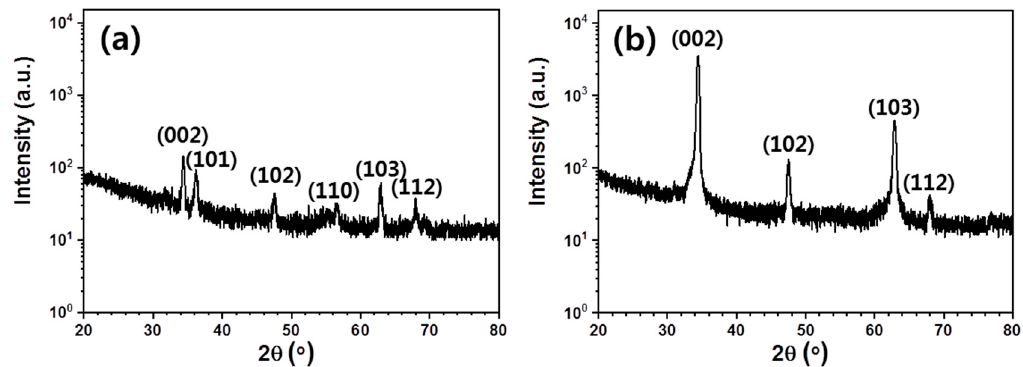
Figure 2. XRD data for ( a ) solution-seeded ZnO nanorods, and ( b ) sputter-seeded ZnO nanorods. The distribution of diffraction planes is more varied in sputter-seeded nanorods. Peaks are labeled with their corresponding lattice indices. The areas under each labeled peak were fit with Gaussians to determine the distribution of rod angles.